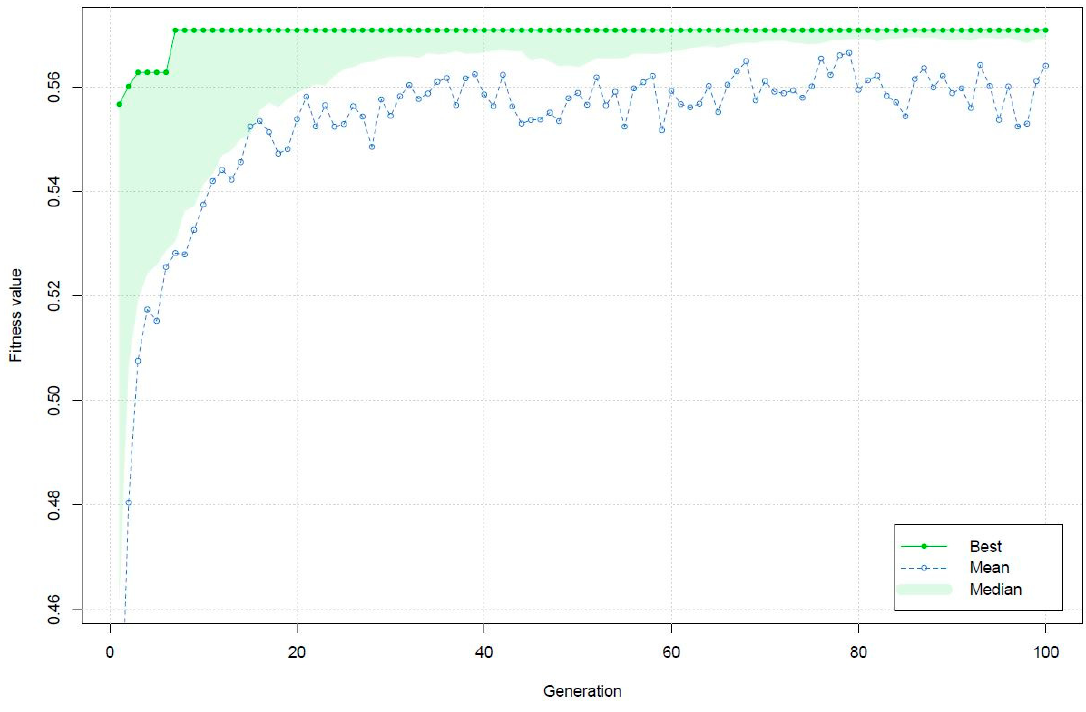
Figure 7. Plot of best, mean and median fitness values recorded during the iterations of the genetic algorithm. The fitness value represents the overall desirability.